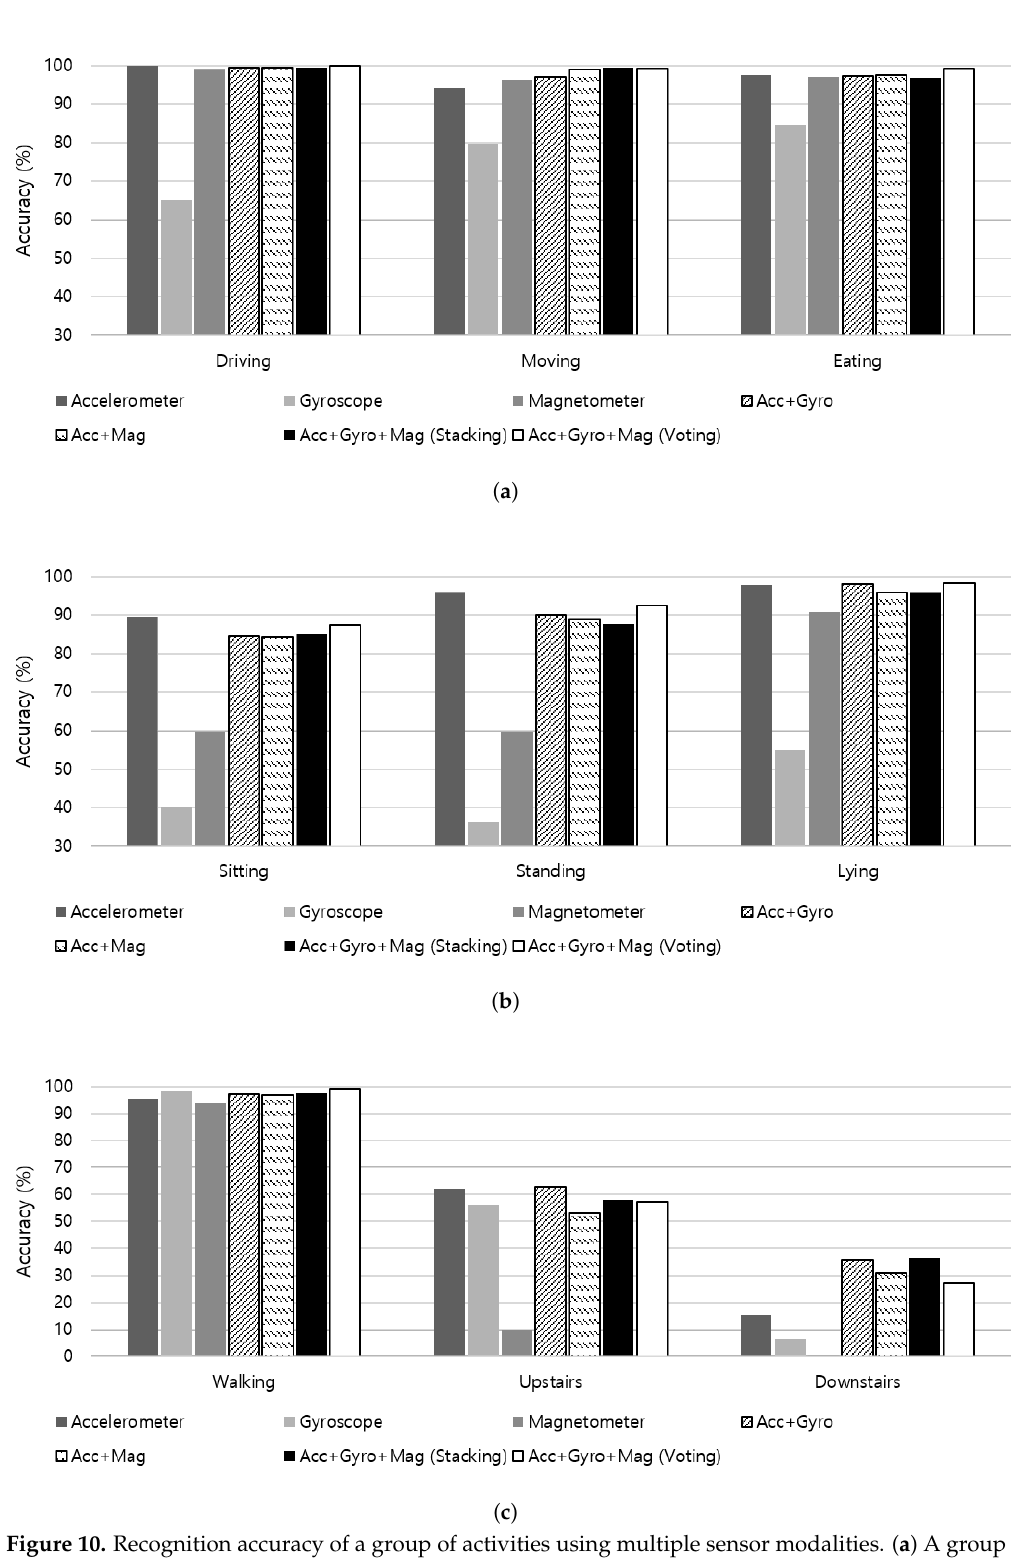
Figure 10. Recognition accuracy of a group of activities using multiple sensor modalities. ( a ) A group of combinatorial activities of sitting, including driving, moving in a car (as a passenger), and eating; ( b ) A group of static activities including sitting, standing, and lying; ( c ) A group of activities that involves walking, including walking upstairs and walking